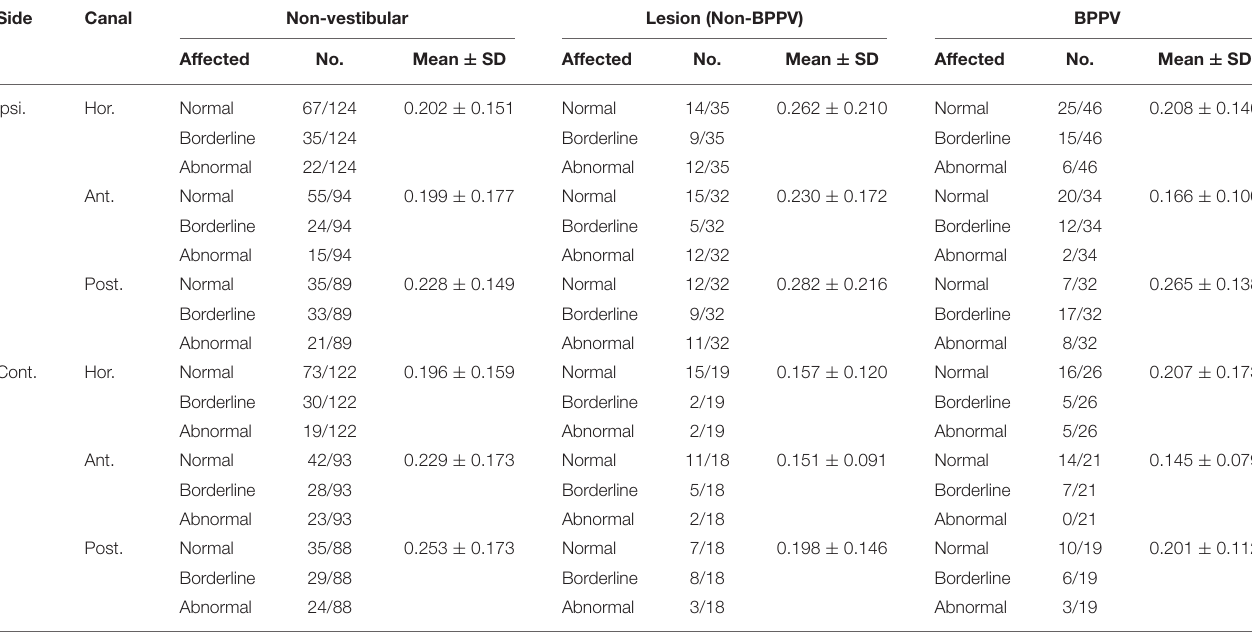
TABLE 1 | Summary of mean htDVA scores for Non-vestibular, Lesion (Non-BPPV), and BPPV groups as well as the proportion of participants classified as Normal, Borderline, and Abnormal ( ≤ 0.158, > 0.158, and ≤ 0.316, > 0.316 logMAR, respectively). Side Canal Non-vestibular Lesion (Non-BPPV) BPPV Affected No. Mean ± SD Affected No. Mean ± SD Affected No. Mean ± SD Ipsi. Normal